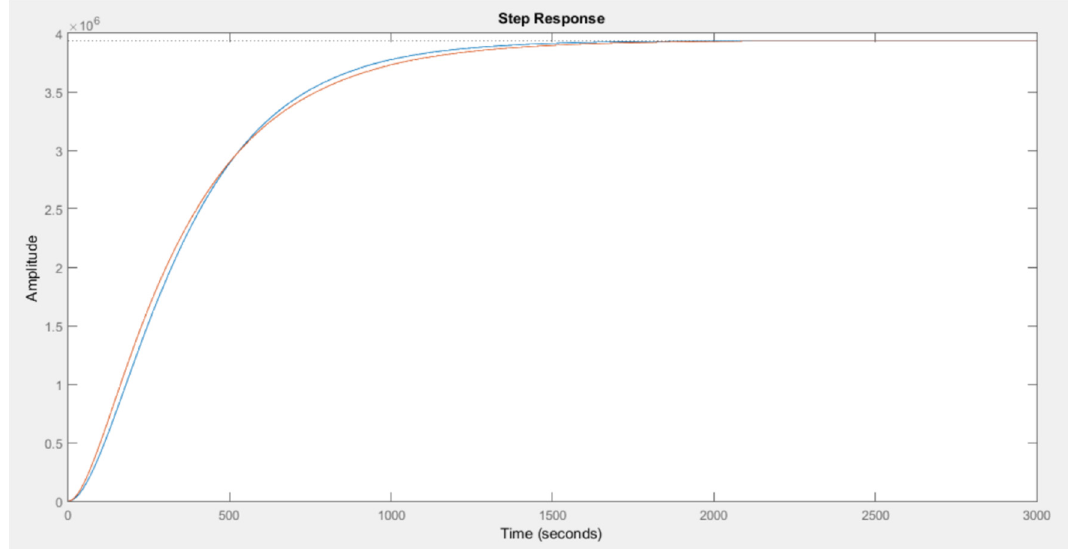
Figure 6. Length = 50 km, diameter = 0.7 m, mass flow = 120 kg/s.